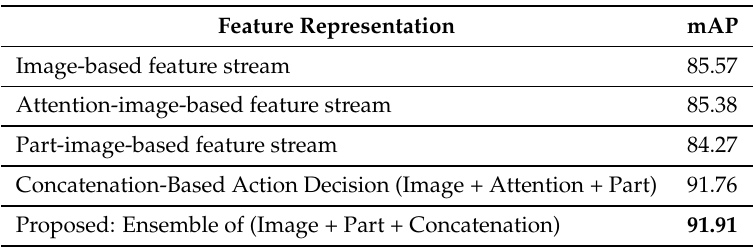
Table 3. Comparison of mAP obtained through feature representation from multiple streams for action recognition on the Stanford 40 Actions Dataset [15]. Bold font indicates the best